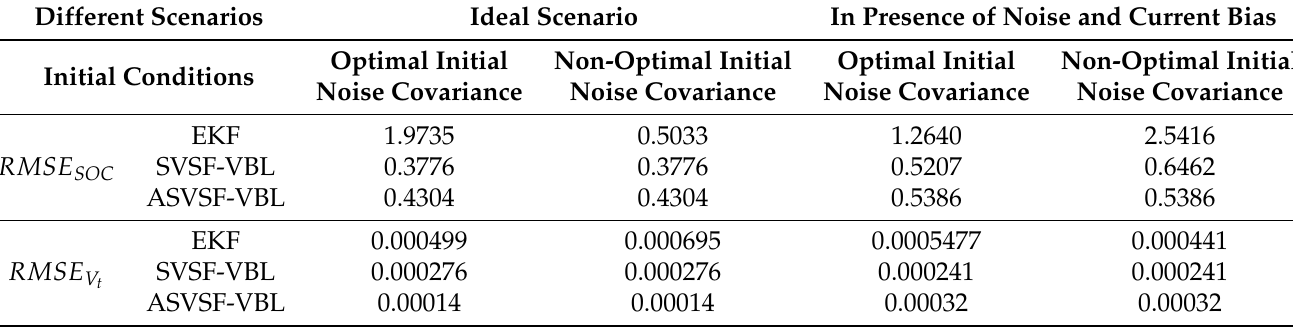
Table 4. Root mean square errors of ASVSF-VBL in comparison with SVSF-VBL and EKF for different scenarios. Different